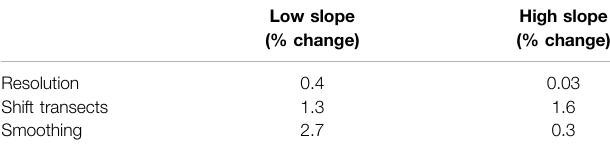
TABLE1| Resultsofaccuracyassessmentsforslopevaluesattwotestlocations. The test location on the Delmarva Peninsula (37.723705 ° N, 76.460207 ° W) is representativeoflowslopeenvironments;thetestlocationonthewesternshoreof Chesapeake Bay (37.870196 ° N, 75.642964 ° W) is representative of higher slope environments along river